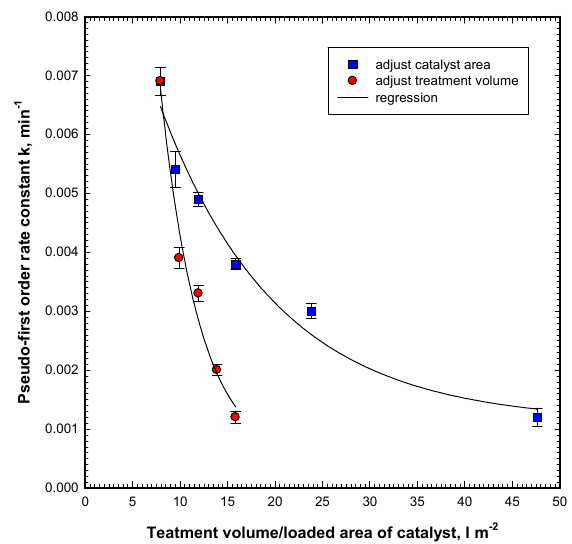
Figure 9. Effect of unit treatment volume on the first-order rate constant by the Vis/ZnO process. The operating conditions were the same as in Figures 7 and 8.